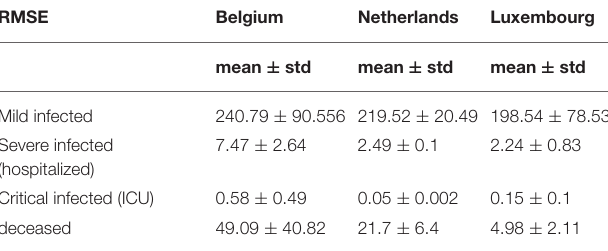
TABLE 4 | Root mean square error between simulated and official statistical data for Belgium, Netherlands and Luxembourg using SEIRD model.